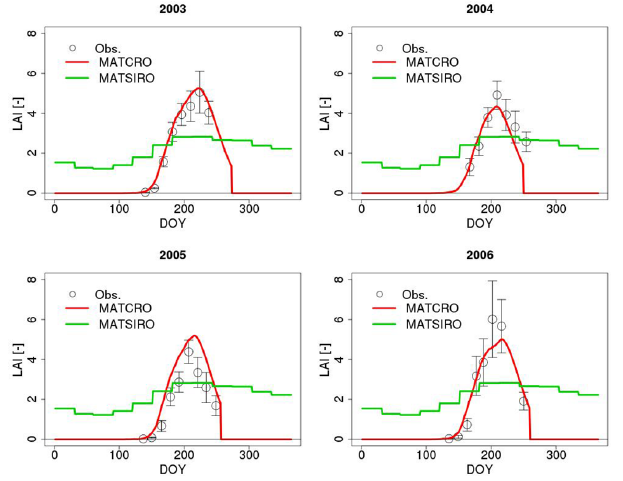
Figure 14. Comparison of LAI between observations, simulations by MATCRO, and the default value of